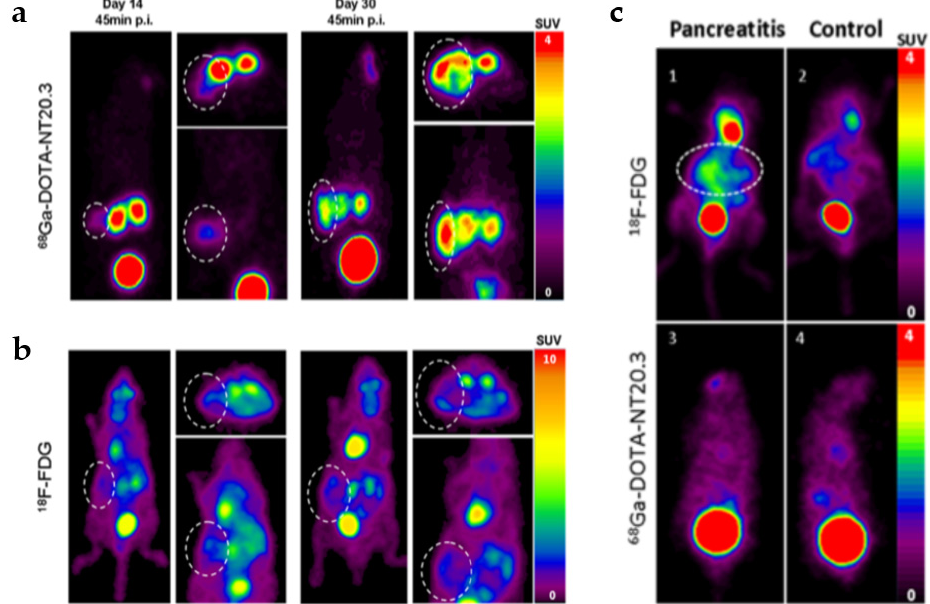
Figure 2. PET imaging 45 min post injection of [ 68 Ga]DOTA-NT-20.3 ( a ) and 18 F-FDG ( b ) in an orthotopic PC model. Circles delineate the tumors. Uptake by normal tissues was observed with 18 F-FDG ( b ) compared to the low uptake obtained with 68 [Ga]DOTA-NT-20.3 ( a ). In vivo PET images of mice with pancreatitis and control mice with 18 F-FDG and [ 68 Ga]DOTA-NT-20.3 ( c ) In mice with acute pancreatitis, 18 F-FDG uptake was elevated, in contrast with low uptake in control mice ( c , upper panel ). [ 68 Ga]DOTA-NT-20.3 PET imaging did not show radiotracer uptake in any case ( c , bottom panel ), reprinted with permission from Ref [74]. Copyright 2019 Copyright American Chemical Society (ACS).